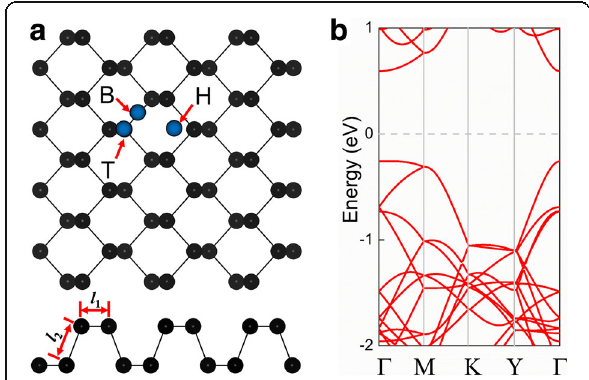
Fig. 1 a Top and side views of the crystal structure of pristine phosphorene (4 × 3 × 1 supercell). The blue circles represent typical positions of an impurity atom adsorbed at a hollow spot (H), on a bridge (B) between two phosphorus atoms, and on top of a phosphorus atom (T). b Electronic band structure and first Brillouin zone of pristine phosphorene; the Fermi level is set to